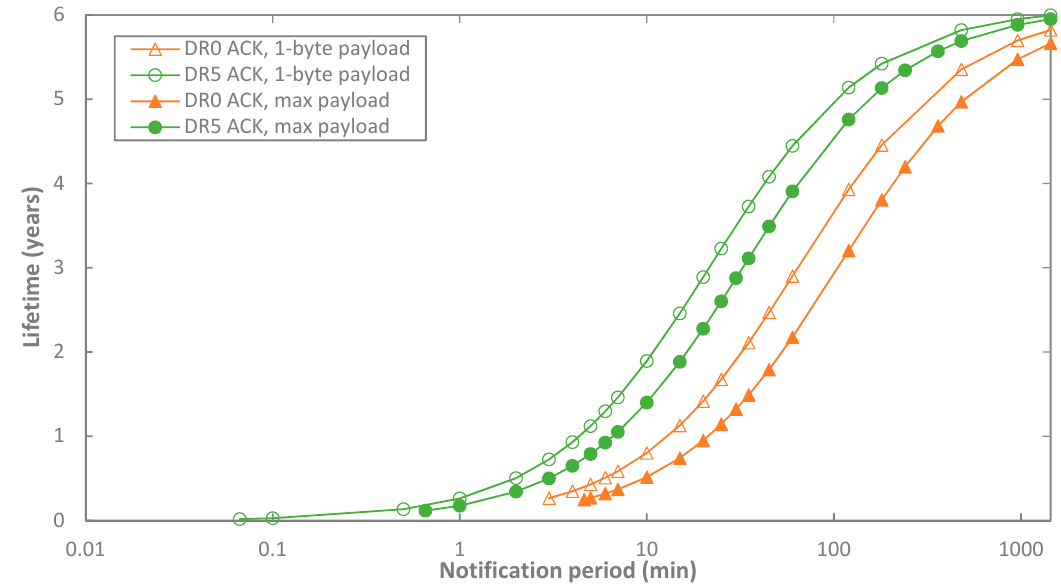
Figure 15. Comparison of the end-device lifetime with 1-byte and maximum-sized payload data message in acknowledged transmission, as a function of T Notif , for BER = 0, p coll = 0, and for different DR settings. Only DR0 and DR5 are shown in the figure for the sake of illustration clarity.